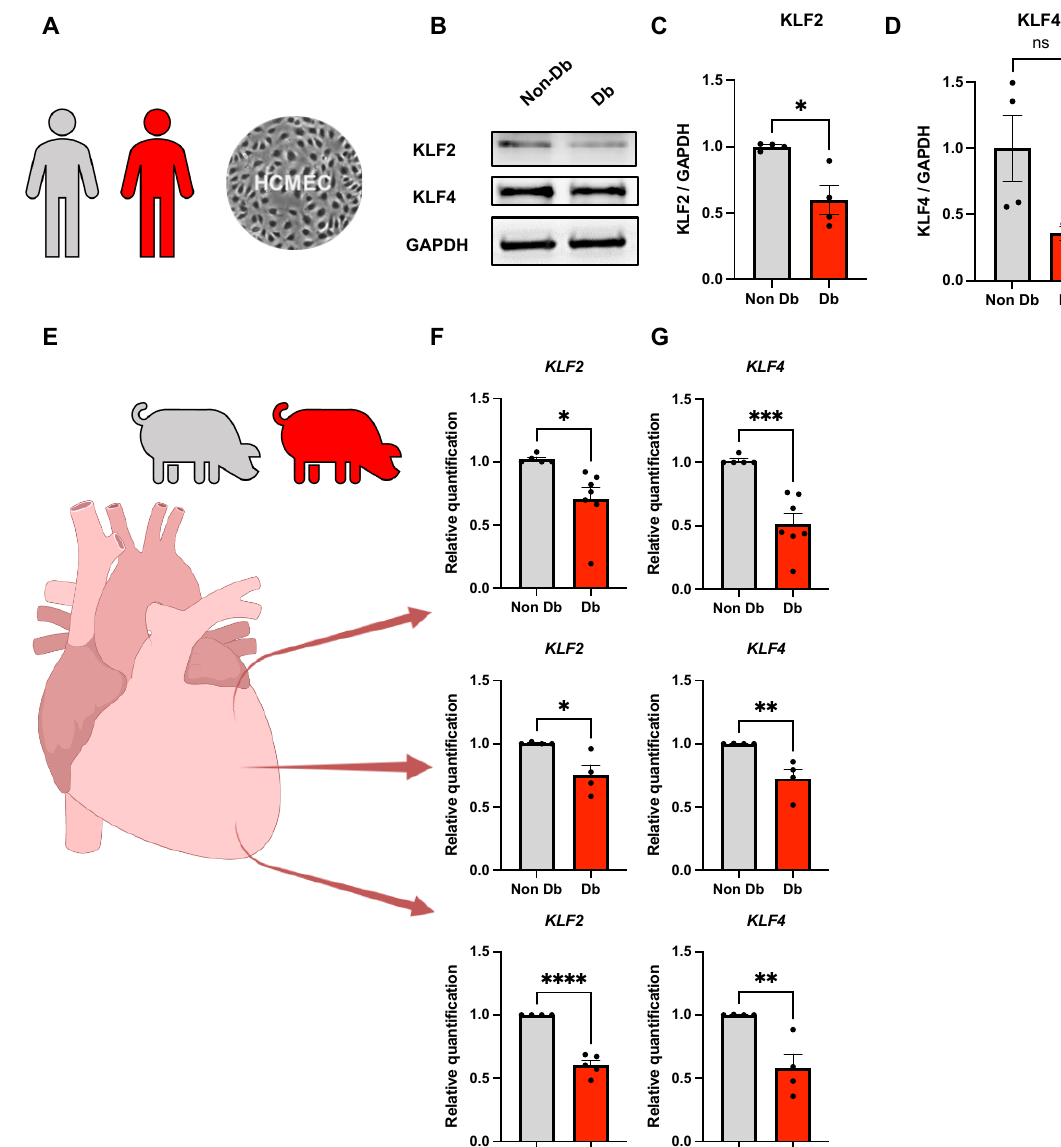
Figure 1. Expression of KLF2 and KLF4 in diabetic HCMECs and diabetic pig hearts. ( A ) Primary HCMECs isolated from nondiabetic or type 2 diabetic males. ( B – D ) Western blot analysis of relative expression and representative blot of KLF2 and KLF4 in protein lysates from nondiabetic or diabetic donors normalized to GAPDH as a housekeeping protein (n = 4). ( E ) Samples from ventricular tissue of nondiabetic or INS C94Y diabetic pigs over the cardiac long axis. ( F , G ) Quantitative PCR analysis of KLF2 and KLF4 from base to apex, respectively. Statistical analyses by unpaired Student’s t -test ( n ≥ 3); * p < 0.05; ** p < 0.01; *** p < 0.001; **** p <